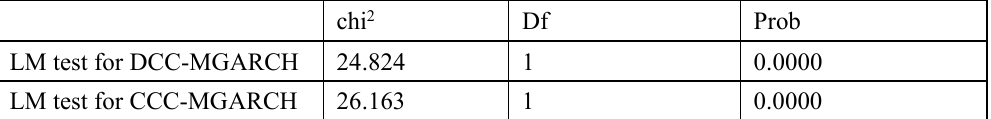
Table 5. LM Test for DCC and CCC-MGARCH of South Africa Sovereign Bond chi 2 Df Prob LM test for